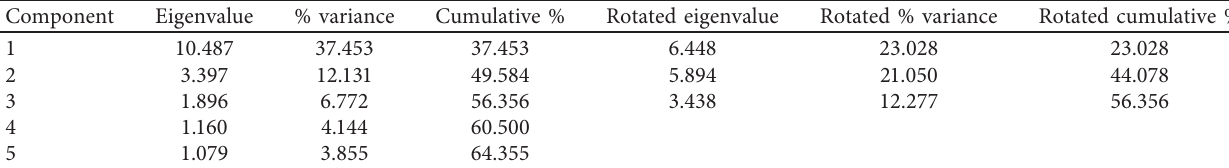
Table 3: Eigenvalues for AMS.